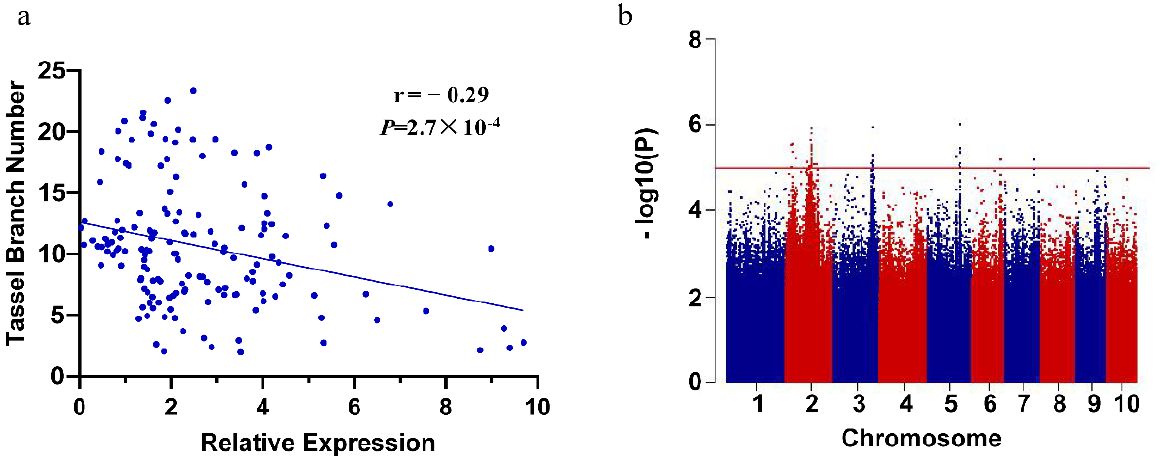
Figure 4. eQTL analysis for ZmPAT7 : ( a ) the expression of ZmPAT7 at the V5 stage negatively correlated with TBN ( b ) Manhattan plot for eQTL analysis, with the suggestive threshold of 1.0 × 10 − 5 . Table 3. List of eQTL for ZmPAT7 and the annotation of candidate genes.